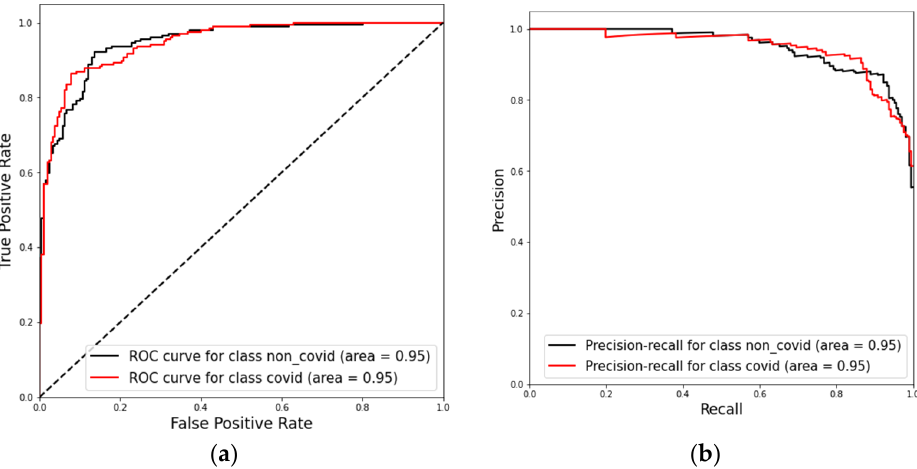
Figure 11. Present the ROC-AUC ( a ) and PR-AUC ( b ) results for model evaluations on the combined test dataset.